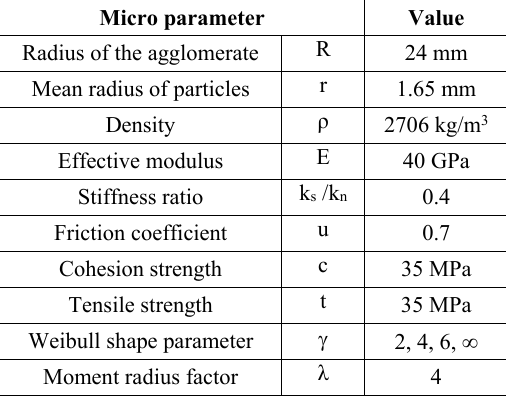
Table 1. DEM simulation